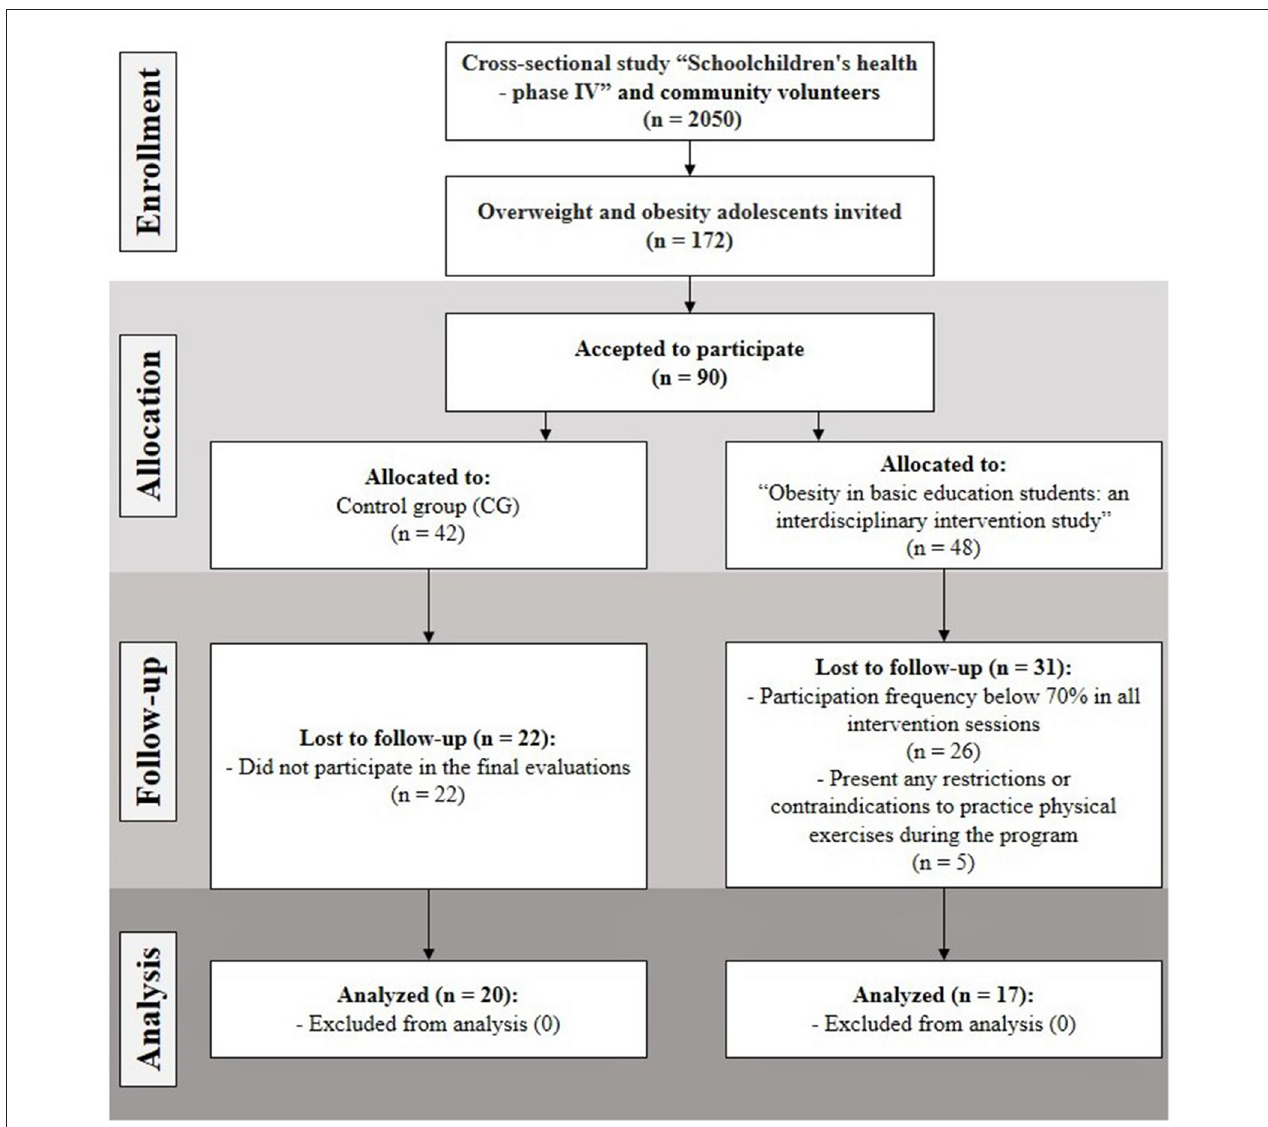
FIGURE 1 | Sample